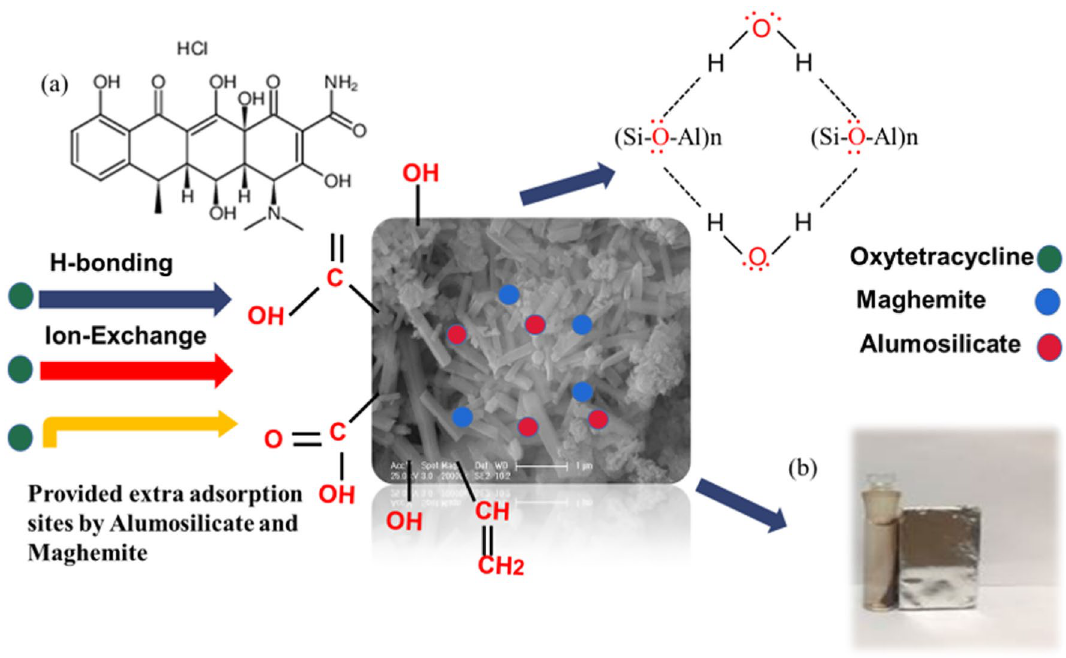
Figure 10. The adsorption mechanism of OTC on Na500, ( a ) OTC structure, ( b ) magnetic separation of adsorbents after